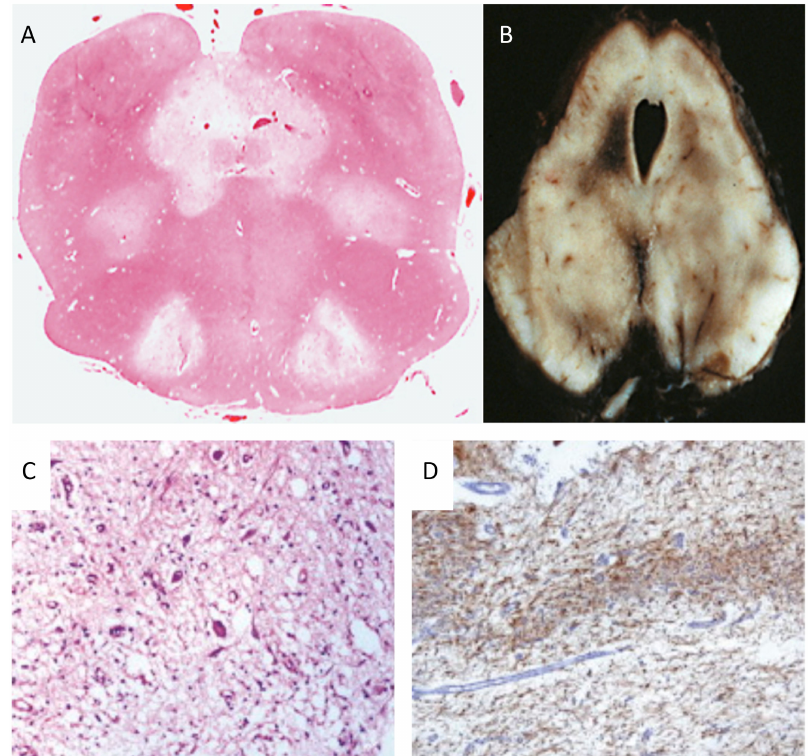
Figure 2. Neuropathology in Leigh disease. ( A ) necrotizing lesions in the medulla oblongata (H&E) and ( B ) mesencephalon (autoptic specimen). ( C ) H&E staining showing neuronal loss, microcystic cavitation of the neuropilum, vessel proliferation, and microgliosis; ( D ) GFAP immunohistochemistry shows marked gliosis in the dentate nucleus. Adapted and modified from: